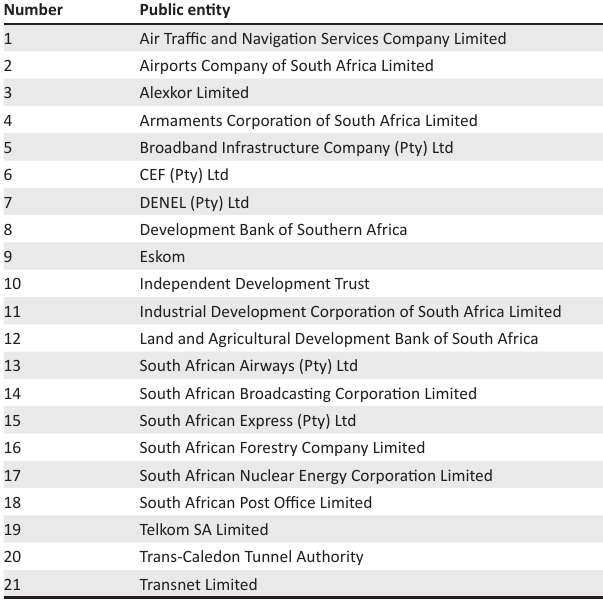
TABLE 1: Schedule 2 public entities as at 30 April